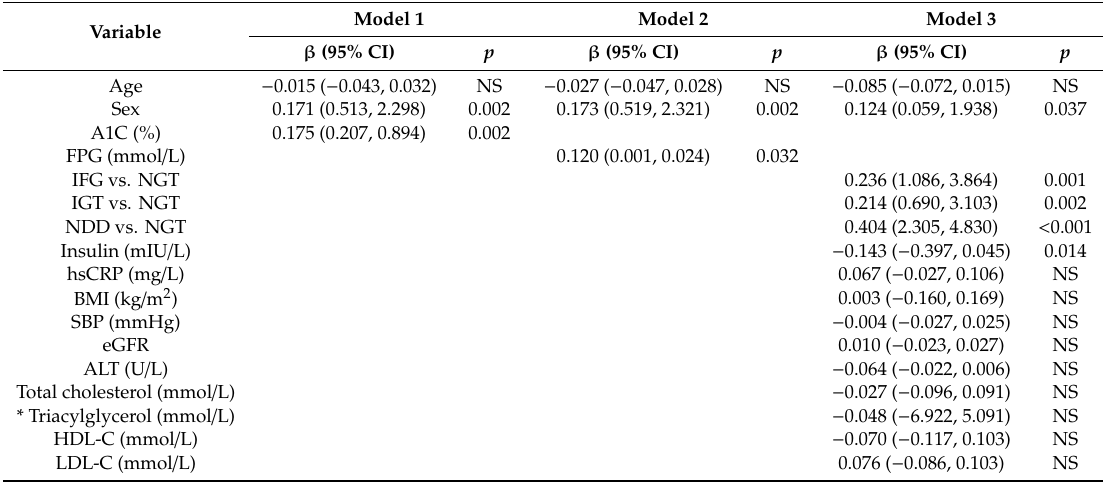
Table 2. Results of a multivariate linear regression analysis between Hhip and clinical variables.